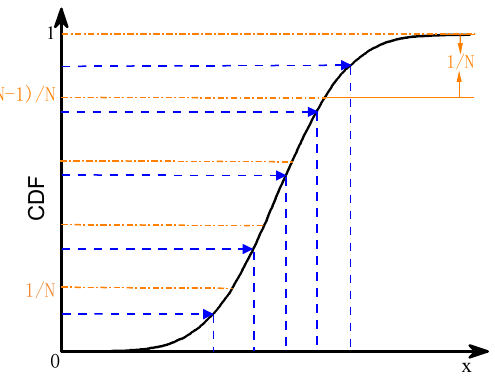
Figure 6. Latin hypercube sampling (LHS).